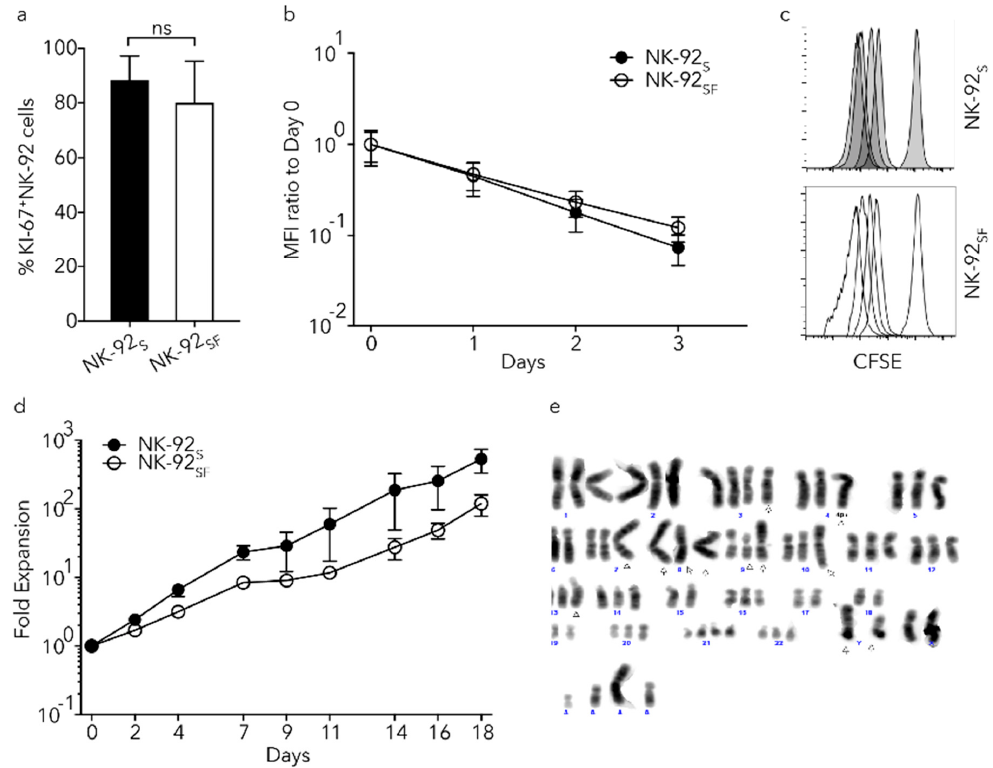
Figure 2. Proliferation of serum-free NK-92 cell culture is slightly reduced. ( a ) Staining of NK-92 S/SF cells for KI-67 as a measurement of proliferation. Each bar represents the mean (+SD) of eight independent assays performed in duplicates. ( b ) Cell division between NK-92 S and NK-92 SF cells was monitored for three days. Analyzed by comparing intracellular carboxyfluorescein succinimidyl ester (CFSE) dilution to day 0. Each data point represents the mean (±SD) of two independent assays performed in triplicates. ( c ) Representative CFSE histograms for four consecutive days. ( d ) Cell division of NK-92 cells was monitored for 18 days after the recovery phase and fold expansion was calculated compared to day 0. The graph shows one representative experiment where each data point represents the mean (±SD) of triplicates. ( e ) Representative karyotyping picture from NK-92 SF cells after the recovery phase. Arrowheads show previously published alterations of the chromosomes in NK-92 cells. Colors were inverted from the original image. ( a ): Welch’s t -test was used.